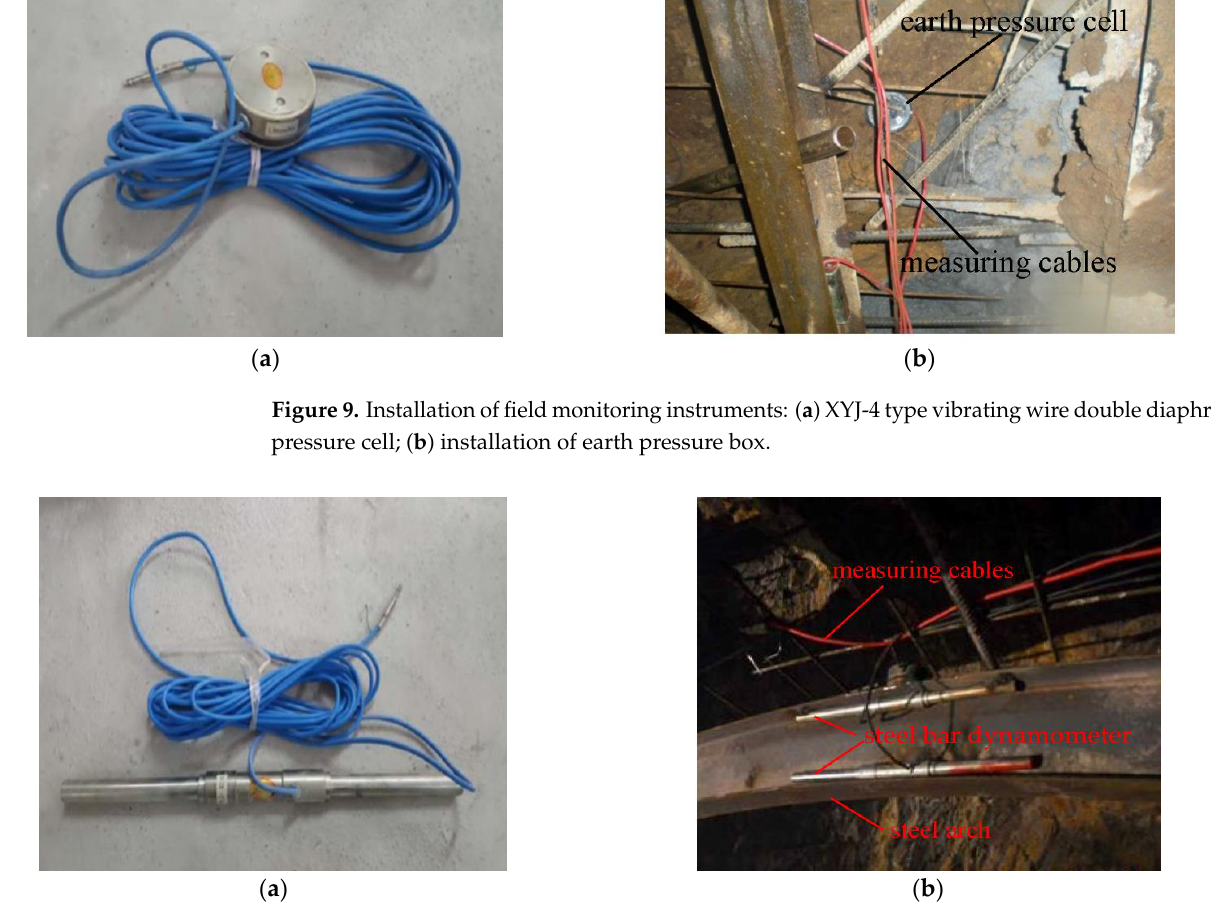
Figure 10. Installation of field monitoring instruments: ( a ) CL-XZ-B type steel bar dynamometer; ( b ) buried steel bar dynamometer on site.